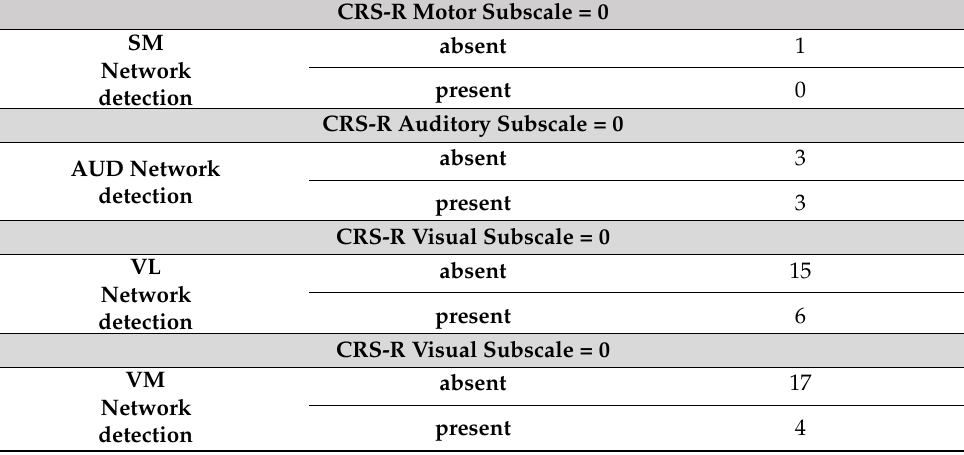
Figure 3. The integrity of the medial visual (MVIS) and lateral visual (LVIS) networks, measured with SBA, correlates with the complexity of the visual response and therefore with the level of consciousness assessed with the CRS-R visual subscale. Results of the nonparametric correlation are thresholded voxelwise at p uncorrected <0.05 (in red) and p family-wise error (FWE) p < 0.05 (in green). Table 4. Number of patients with zero score at the CRS-R subscales, for whom rs-fMRI networks was deemed present or